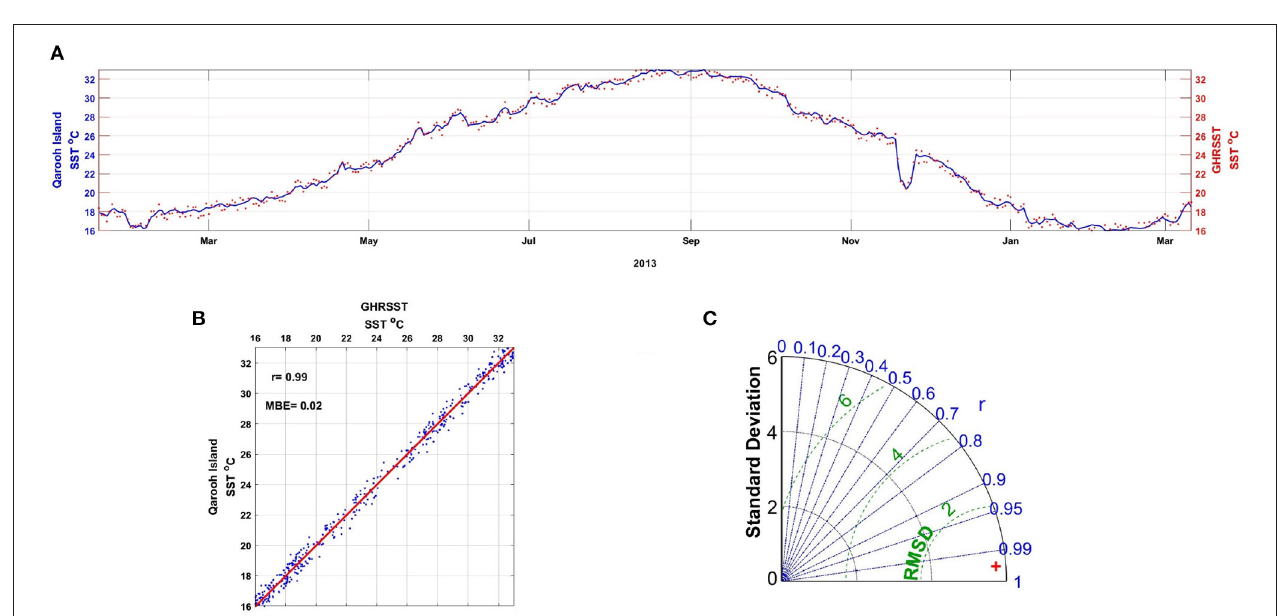
FIGURE 2 | (A) Daily SST observations (January-2013 to March 2014) from GHRSST (red) and Qarooh Island station, Kuwait (blue), (B) comparison of daily SSTs from GHRSST and Qarooh Island observations. A linear fit to the data, using robust regression is represented by the solid red line. (C) Taylor diagram (Taylor, 2001) summarizing results of comparison between GHRSST and Qarooh Island observations from SST.